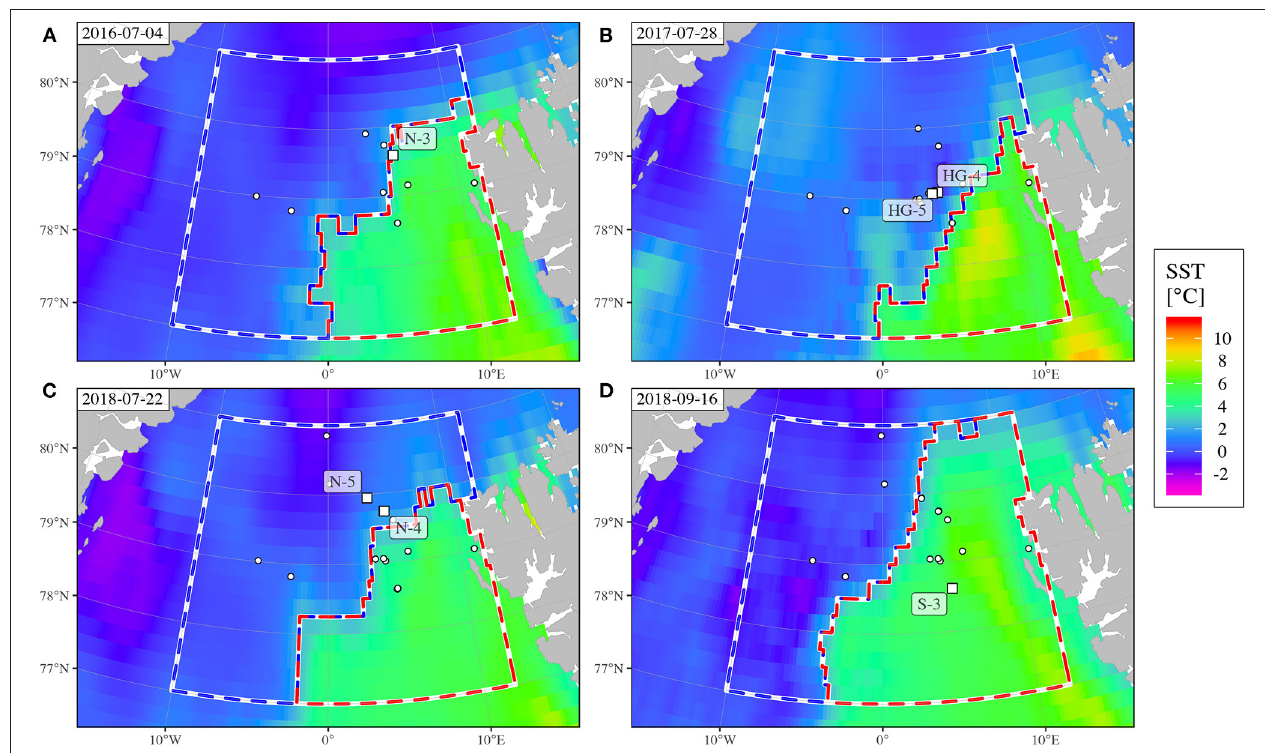
FIGURE 3 | Distinction of Polar (cold, blue dashed line) and Atlantic (warm, red) sections of the study site during the four sampling campaigns. The four snapshots [2016-07-04, PS99 (A) , 2017-07-28, PS107 (B) , 2018-07-22, PS114 (C) , 2018-09-06, MSM77 (D) ] illustrate the horizontal variability of the front system. Labeled white squares mark stations sampled on the respective days, remaining stations are indicated as white